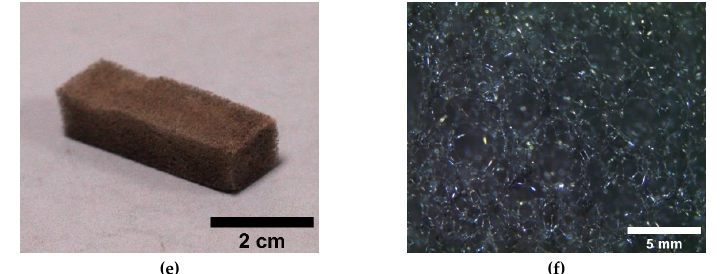
Figure 2. Photographs of the untreated ME ( a ) and treated ME/PDMS/Au ( c ) and ME/PDMS/Pd ( e ) foams. Optical micrographs (40×) of the untreated ME ( b ) and treated ME/PDMS/Au ( d ) and ME/PDMS/Pd ( f ) foams showing the homogenous color of the struts of the foams. No significant weight changes were found during the production of the ME/PDMS/Au and the ME/PDMS/Pd foams from the ME/PDMS foams, so moderate Au or Pd loads are expected on these samples. This amount of Au or Pd transferred to the foams, upon dipping to the precursor solutions of different concentrations and for different time intervals, was accurately determined by the ICP- OES analysis of the ME/PDMS/Au and ME/PDMS/Pd foams. After 48 h of immersion of the foams in solutions with HAuCl 4 concentrations ranging from 0.175 to 1.400 mg/mL, the transferred Au to the foams was ranging from c.a. 0.6 to 1.0 wt.%. For the precursor concentration of 0.350 mg/mL, the Au transfer already reached c.a. 1 wt.%, and this concentration was chosen for the further analysis of the kinetics of the Au transfer onto the foams. Similarly, ME/PDMS/Pd foams obtained after 48 h of immersion in solutions with Na 2 PdCl 4 concentrations ranging from 0.250 to 2.000 mg/mL showed Pd contents ranging from 0.8 to 1.2 wt.%. Additionally, an intermediate concentration of 0.500 mg/mL, which provides a Pd transfer c.a. 1.1 wt.%, was chosen to study the kinetics of the procedure. It should be noticed that this concentration is also equivalent to the selected Au concentration (i.e., 0.350 mg/mL) in terms of the noble metal ions availability, about 0.200 mg/mL. Thus, a direct comparison between the ME/PDMS/Au and ME/PDMS/Pd foams can be performed. In particular, ME/PDMS/Au and ME/PDMS/Pd foams were produced upon the dipping of the ME/PDMS foams in the HAuCl 4 or Na 2 PdCl 4 solutions for time intervals ranging from 1 to 120 h. As shown in Figure 3, both the Au and Pd amounts transferred to the foam increased with the reaction time increase, starting from about 0.1 wt.% Au and 0.5 wt.% Pd after 1 h of reaction time and reaching a stable value of about 1 wt.% Au and 1.1 wt.% Pd after 48 h. According to these values, the Pd transfer seems to be faster in the beginning, reaching almost 50% of the final load in just 1 h, while the Au transfer reaches about 10% at the same time. However, after 15 h, the transferred amounts of both noble metals became similar.